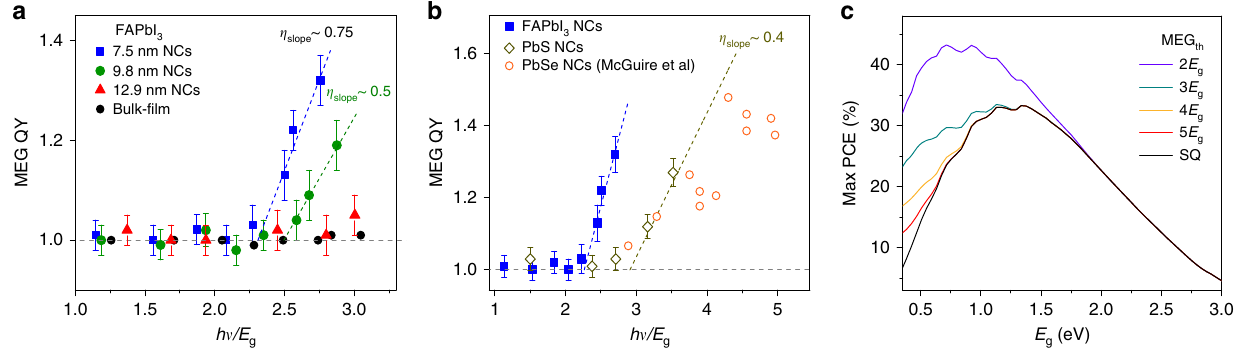
Fig. 3 MEG threshold and slope ef fi ciency determination. a MEG QY as a function of relative pump photon energies ( h ν / E g ) for FAPbI 3 NCs of different edge lengths and bulk-counterpart. b Comparison of MEG QY vs. h ν / E g with PbSe NCs (from ref. 25 ) and PbS NCs ( E g = 1.3 eV) as a reference measured using the same setup. The error bars in a , b represent the uncertainties in the MEG QY fi tting procedure. c Detailed balance calculations for maximum PCEs under AM1.5 solar illumination as a function of material E g for different MEG thresholds. The Shockley – Queisser limit is denoted as